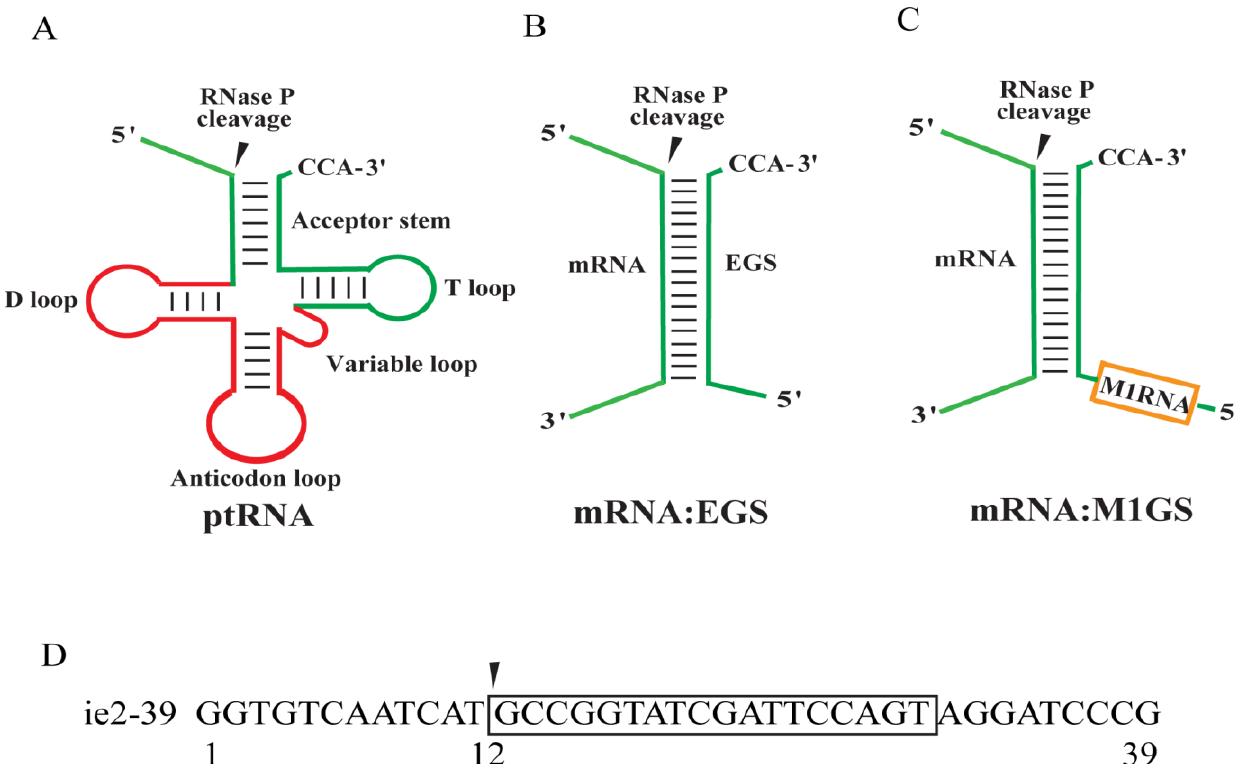
Figure 1. Schematic presentation of RNase P/M1GS ribozyme’s substrates. ( A – C ) pre-tRNA (ptRNA), a natural substrate ( A ); EGS:mRNA complex ( B ); and M1GS binding to its substrate ( C ). Filled arrows denote the cleavage sites. ( D ) Substrate ie2-39 with boxed region representing the complementary sequence to the guide sequence of